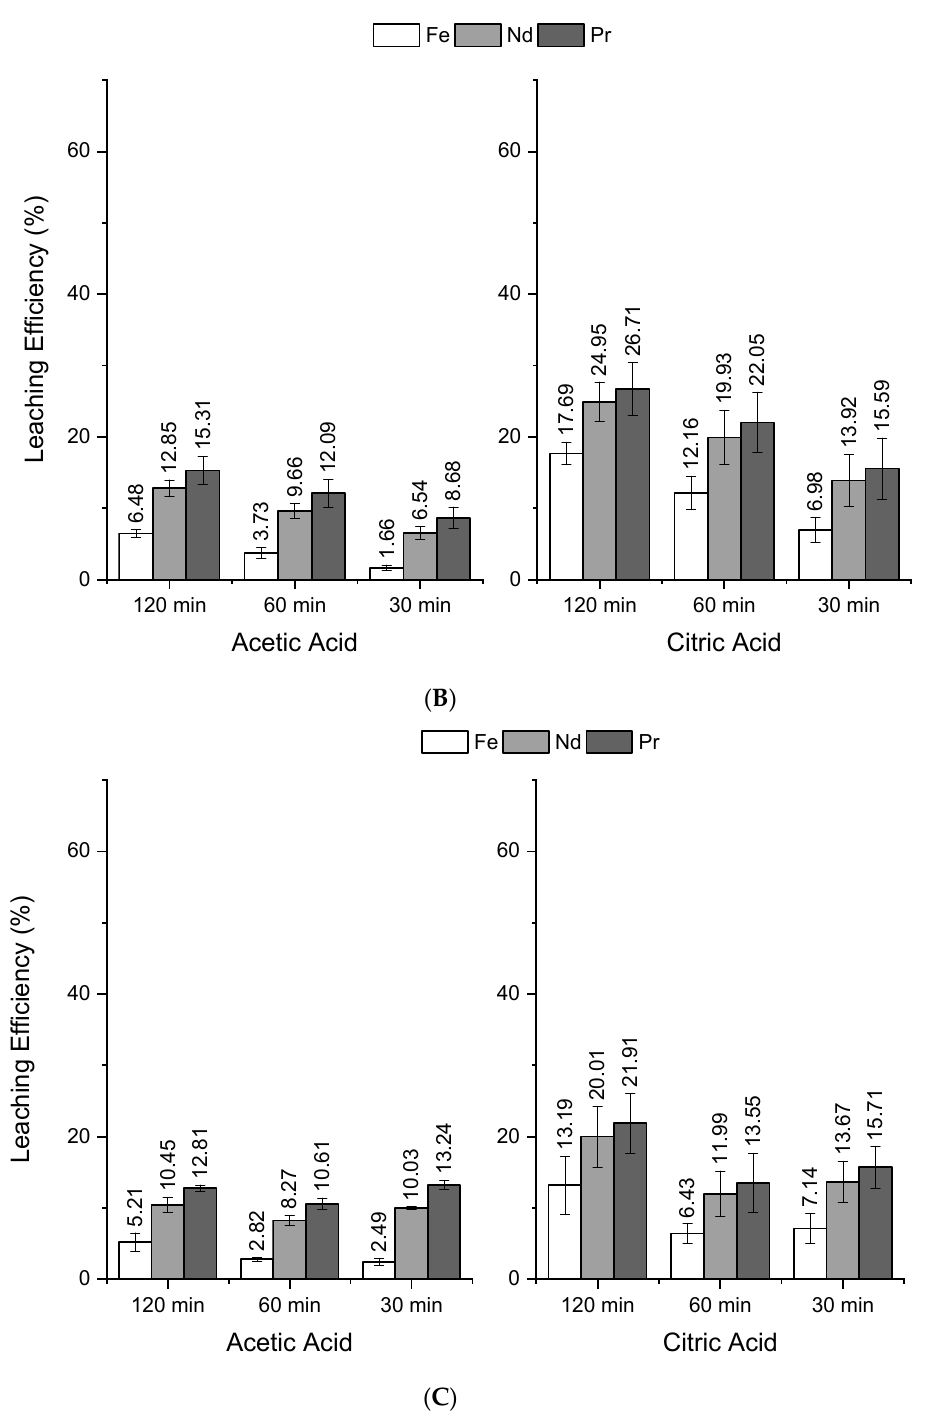
Figure 9. Comparison of the leaching efficiency of NdFeB magnets in acetic and citric acids, concen- tration 0.5 M, ratio s/l ( A ) 1/100; ( B ) 1/50 and ( C ) 1/10.